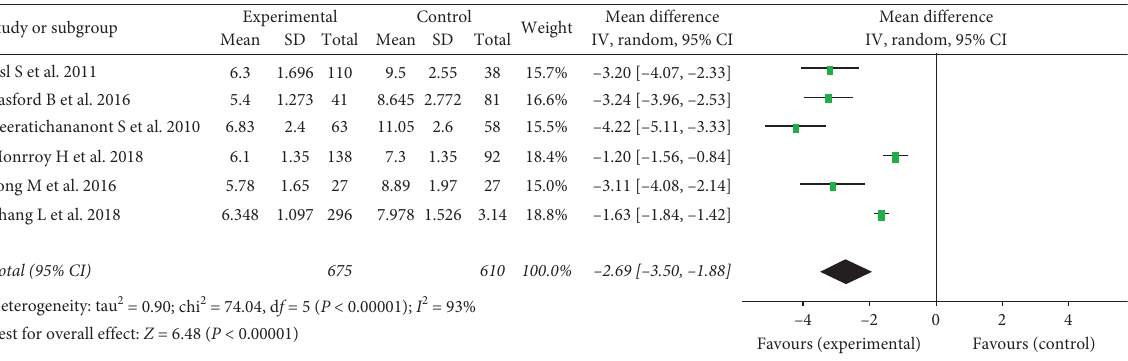
Figure 4: Forest plot of Total Mucosal Visibility Score (McNally) for pooled mucolytic agent vs. control.